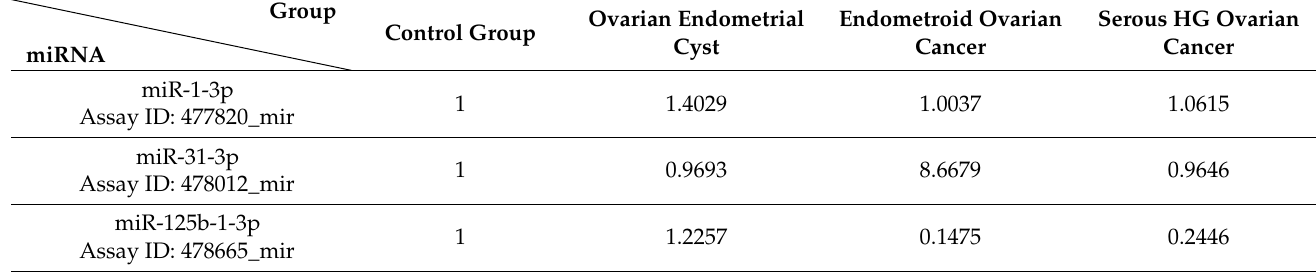
Table 1. Names, assays IDs, and relative expression levels of the miRNAs studied. n = 20 for each group; values shown as